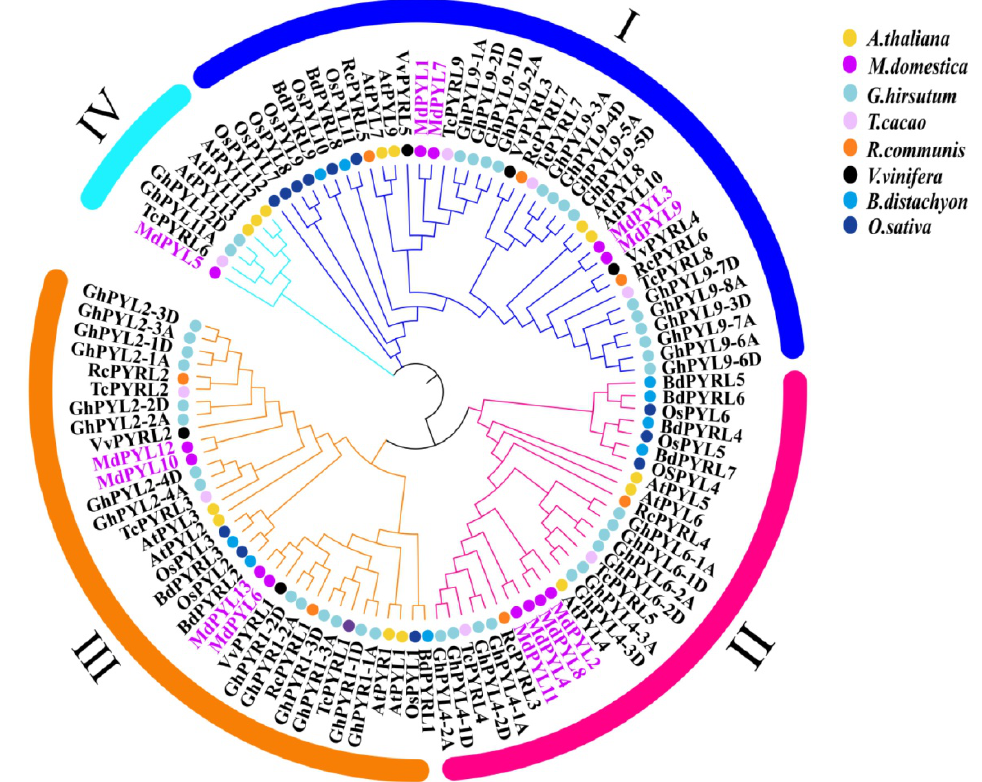
Figure 2. Phylogenetic analysis of PYLs from seven species. Different groups of MdPYLs are indicated in different colors bars. Circles of different colors denote PYLs from different species, including 14 AtPYLs from A. thaliana (yellow dot), 13 MdPYLs from M. domestica (purple dot), 7 RcPYLs from R. communis (orange dot), 5 VvPYLs from V. vinifera (black dot), 9 BdPYLs from B. distachyon (blue dot), 12 OsPYLs from O. sativa (navy blue dot), 9 TcPYLs from T. cacao (pink dot) and 40 GhPYLs from G. hirsutum (light blue dot). All amino acid sequences used in this analysis are listed in Supplementary Table 1.